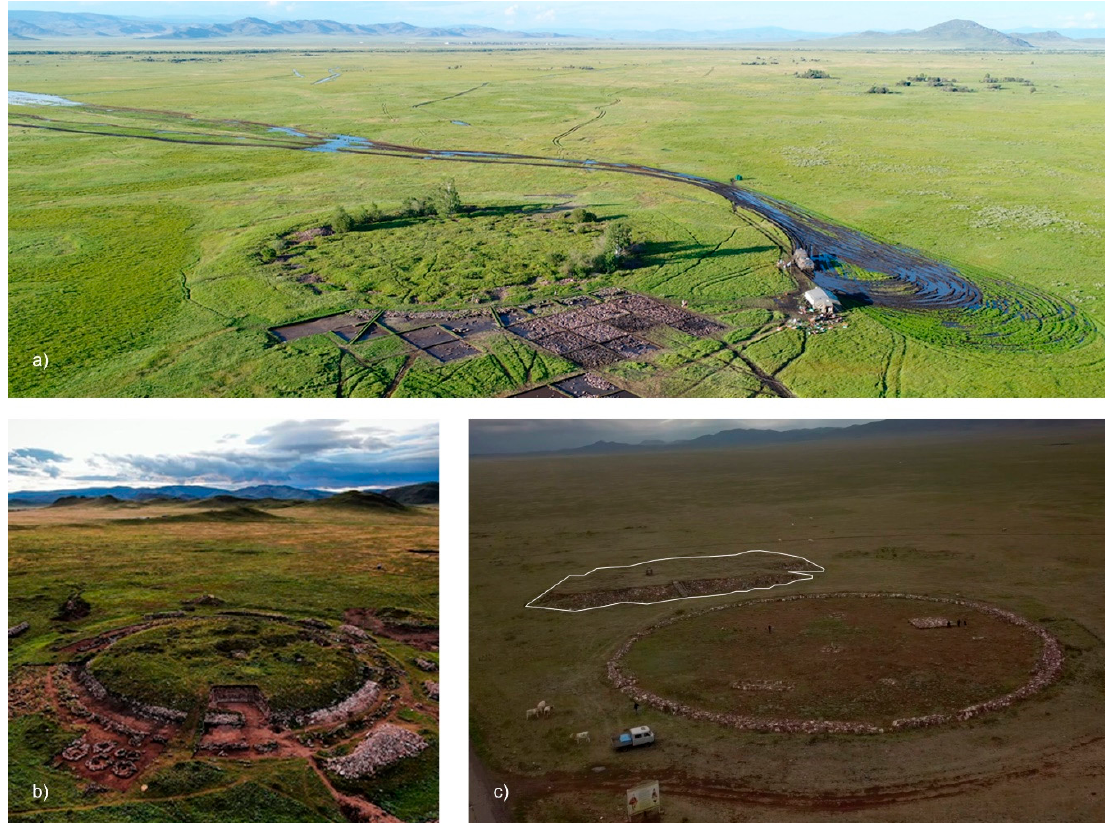
Figure 2. The burial mounds ( a ) Tunnug 1, ( b ) Chinge-tei 1, and ( c ) Arzhan 2. Tunnug 1 and Chinge-tei 1 show very clearly in the PALSAR data. The completely excavated burial mound, Arzhan 2, does not show, but the spoil heap from the excavation (marked with a white outline) is still visible. (Photo credits: Blochin / Wallace).